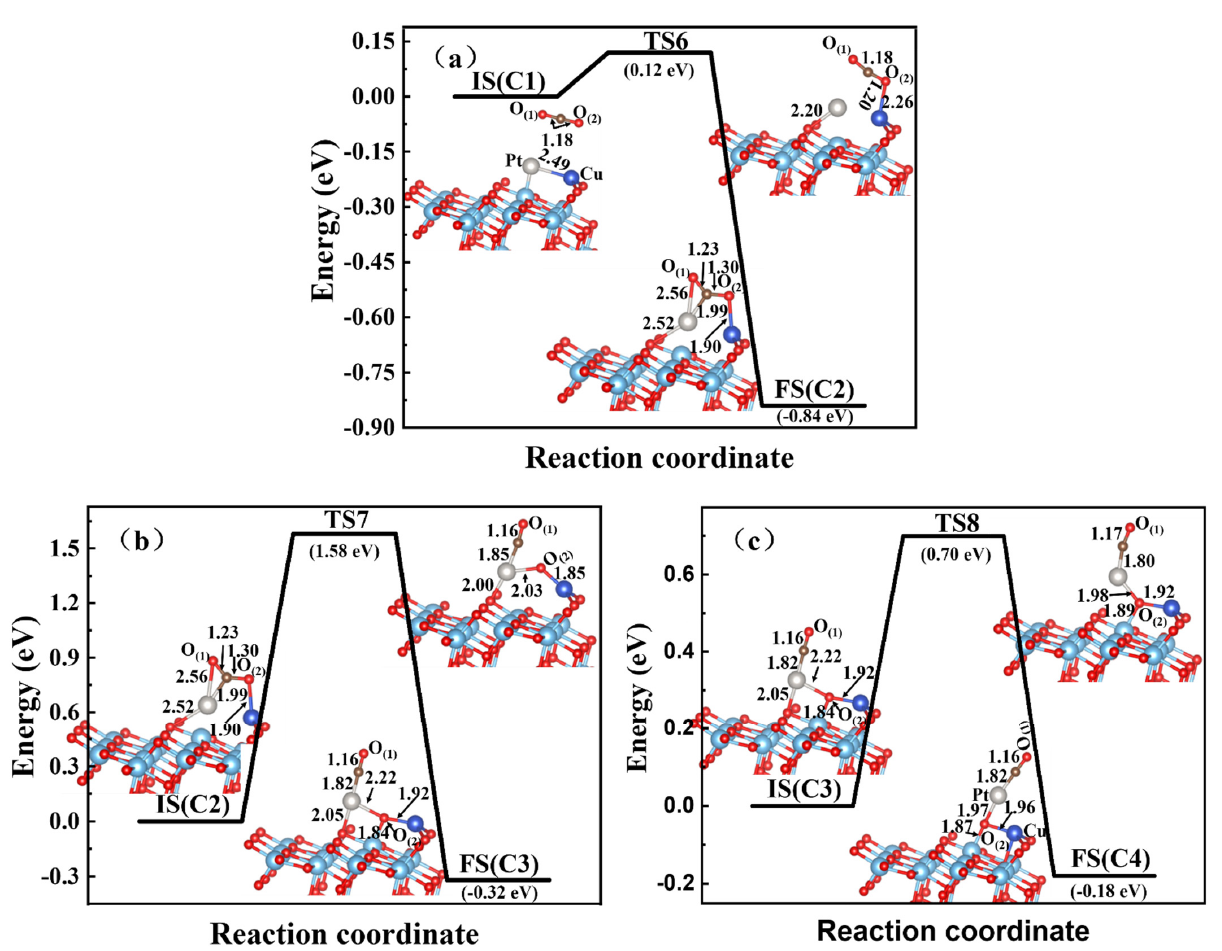
Figure 8. CO 2 reduction on the Cu-Pt-embedded A-TiO 2 (101) surface. The Cu atom in dark blue, Pt atom is pale, and Zn atom in light gray. ( a ) is the adsorption process, ( b ) and ( c ) are the two steps of reduction process.